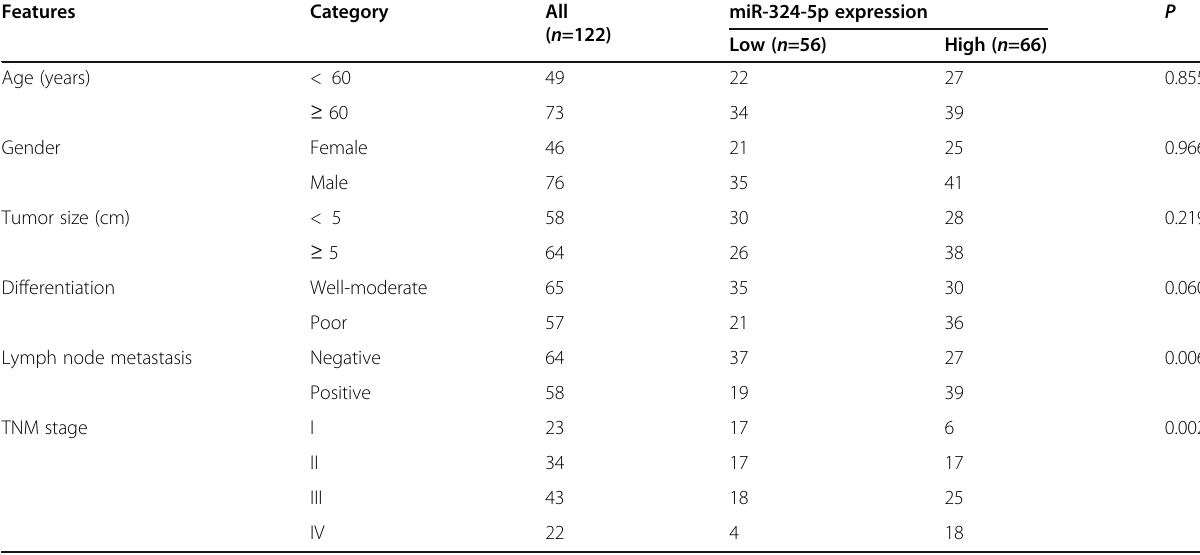
Table 1 Relationship between miR-324-5p and clinicopathological characteristics of gastric cancer patients